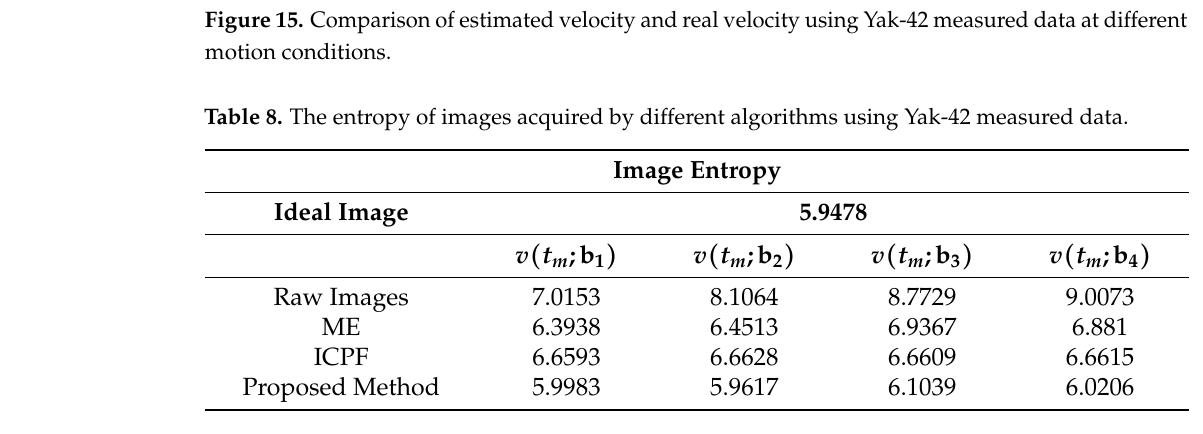
Table 9. Estimated speed RMSE of different algorithms using Yak-42 measured data